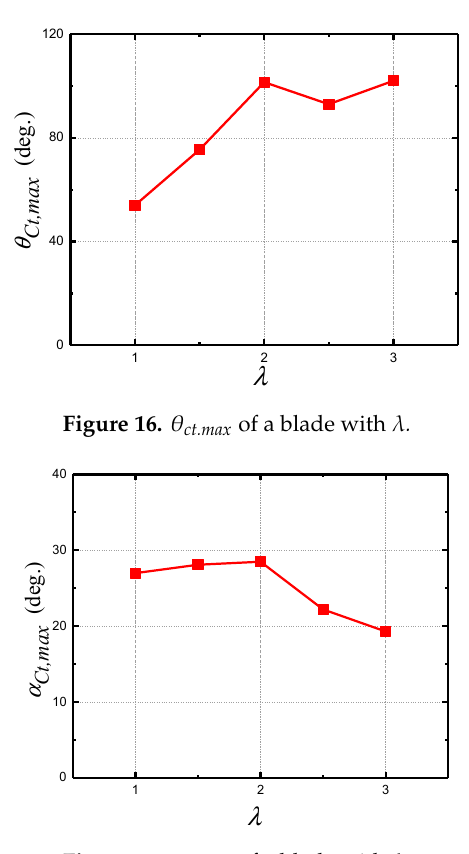
α Figure 17. α ct.max of a blade with λ . Figure 17. ct.max of a blade with Figure 17. α ct.max of a blade with λ . Figure 17. α ct.max of a blade with λ .